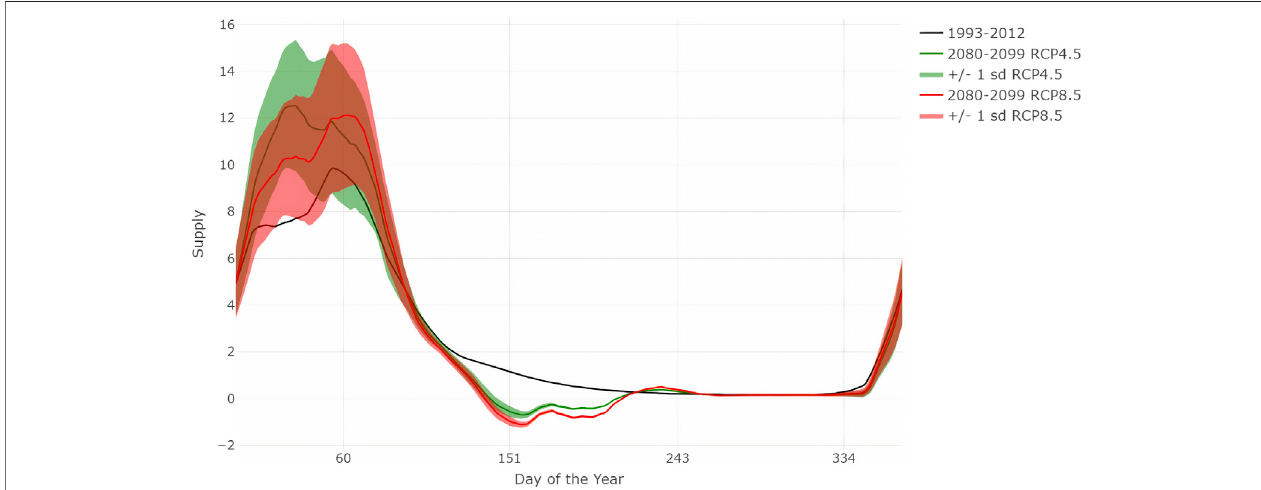
FIGURE5 | Modelled seasonal stream fl ow(measured inm 3 /sec) regimecurvesfor 1993 – 2012 (black), and 2080 – 2099according toRCP4.5 (green) and RCP8.5 (red) scenarios for a station in California (34.35, − 119.31). The shading indicates the uncertainty ( ± one standard deviation).